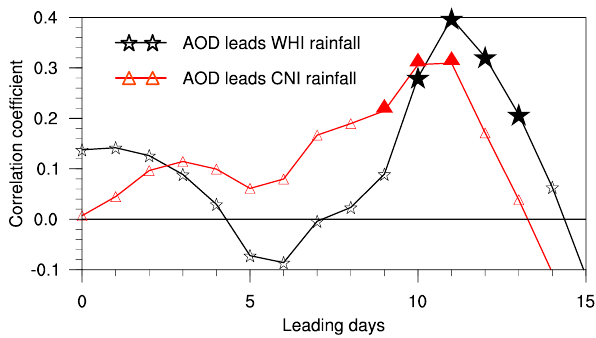
Figure 10. Cross-correlation coefficients between WRF-Chem sim- ulated rainfall responses in WHI and CNI and dust AOD (ALLF mi- nus NDST) in remote DST regions. All correlations are calculated based upon daily anomalies obtained by subtracting the 21-day run- ning mean from the daily data. The filled markers represent that the correlation coefficients with a 95% confidence level based on the t test. The unfilled markers are not